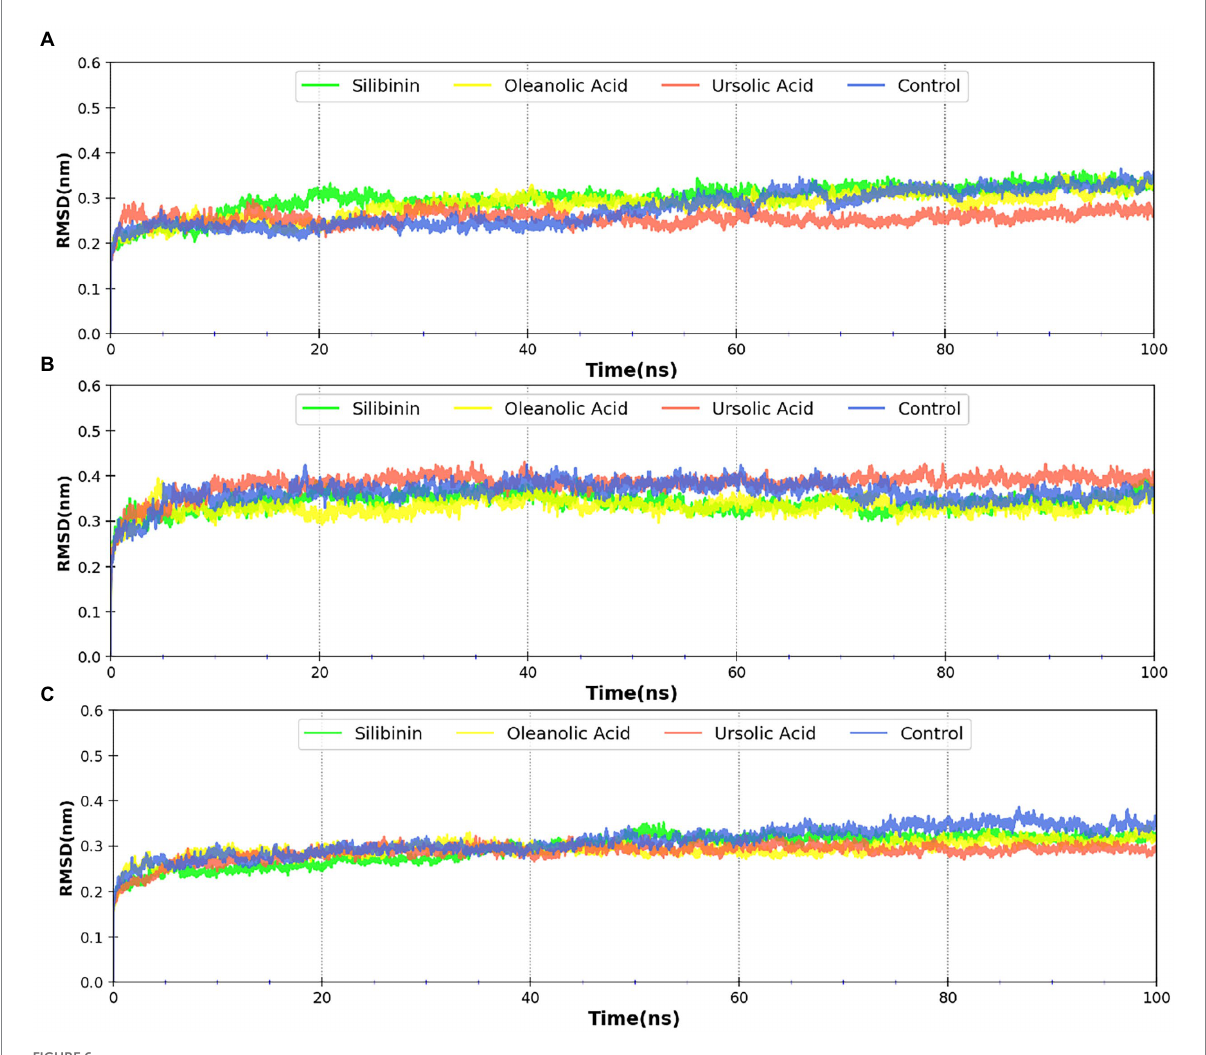
FIGURE 6 RMSD profile of protein backbone bound to phytomolecules in case of (A) A26 protein (B) H3 protein and (C) D13